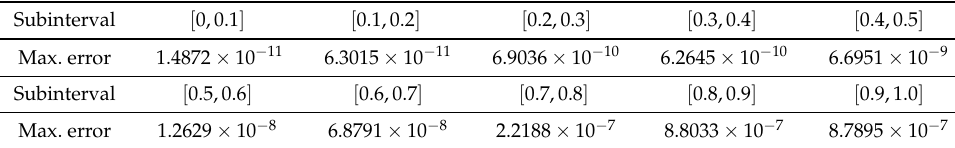
Table 2. Approximation errors for the problem (29).